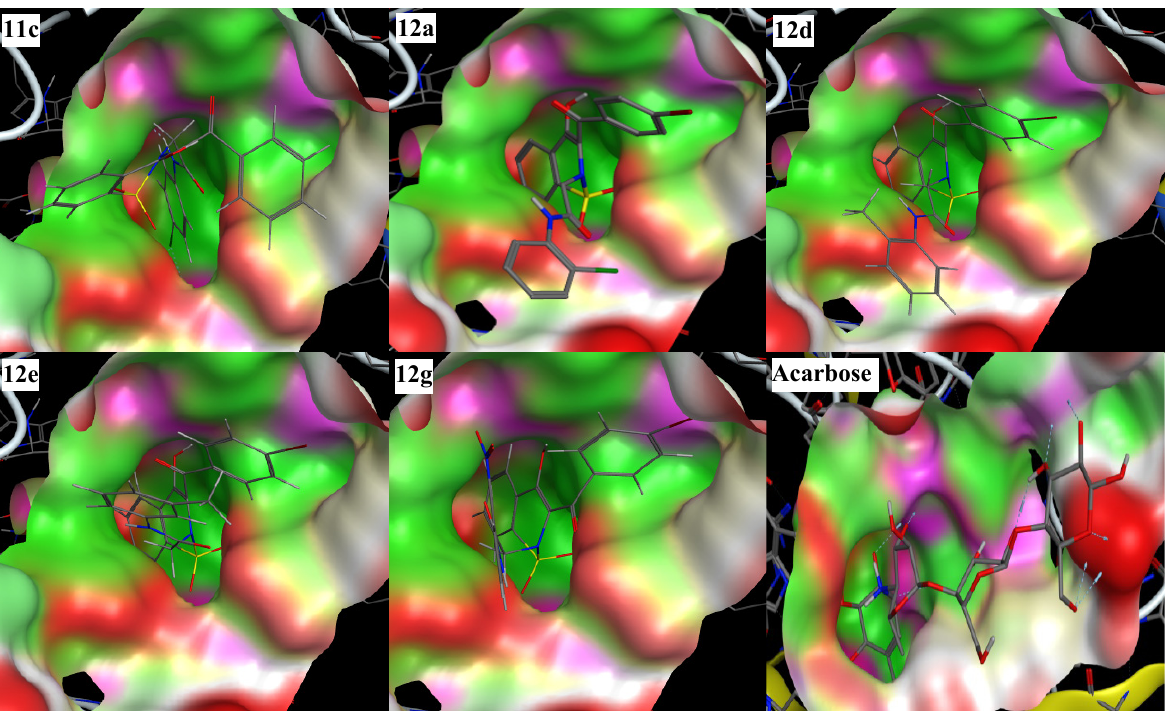
Figure 3. Three-dimensional interaction modes of the most active compounds ( 11c , 12a , 12d , 12e , 12g ) and the standard drug, acarbose. Color portions show pocket selected and red portions indicate the ligand exposure points.